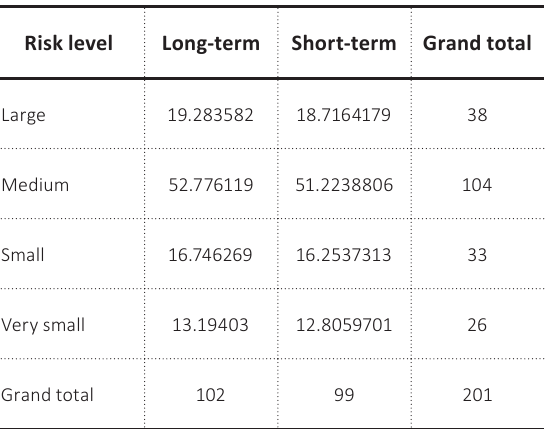
Table 7. Expected frequencies of the impact of taking different levels of risk on the